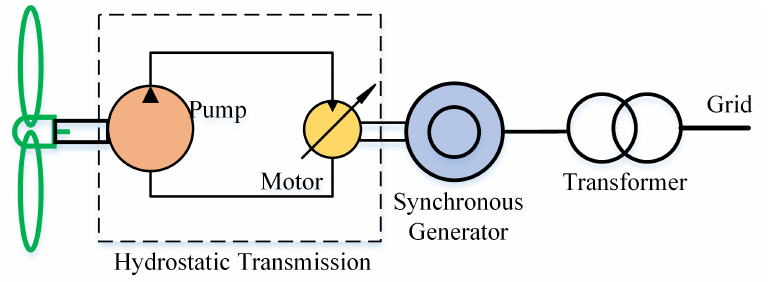
Figure 1. Schematic of an HST drive